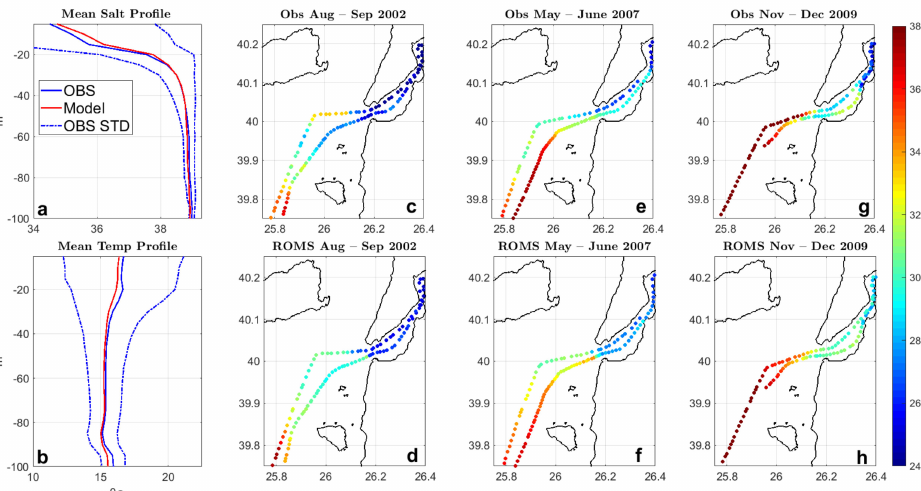
Figure 10. Hydrographic properties at the surface and sub-surface layer—top 100 m—at Turkish Strait System and Dardanelles exit. Panels ( a , b ) show the mean profile of salinity and temperature, respectively at the upper 100 m at the area that is directly affected by the Dardanelles outflow (Figure 1 dashed line rectangle). Panels ( c , e , g ) show the surface—approximately 3 m depth—salinity measured at three hydrographic surveys conducted the years 2002, 2007 and 2009 from a salinograph [41]. Panels ( d , f , h ) show the modelled surface salinity for the same periods and